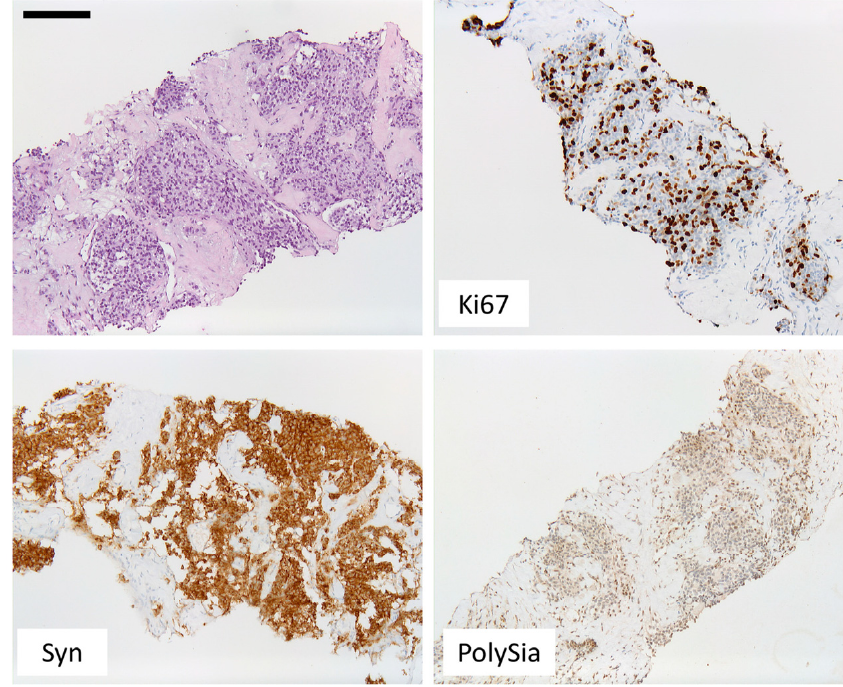
Figure 3. Representative immunohistochemistry of atypical carcinoid (AC) with intermediate proliferation index (Ki-67, 60%), positivity for synaptophysin (Syn) and weak expression of polySia-NCAM (PSS). Bar, 500 µm.